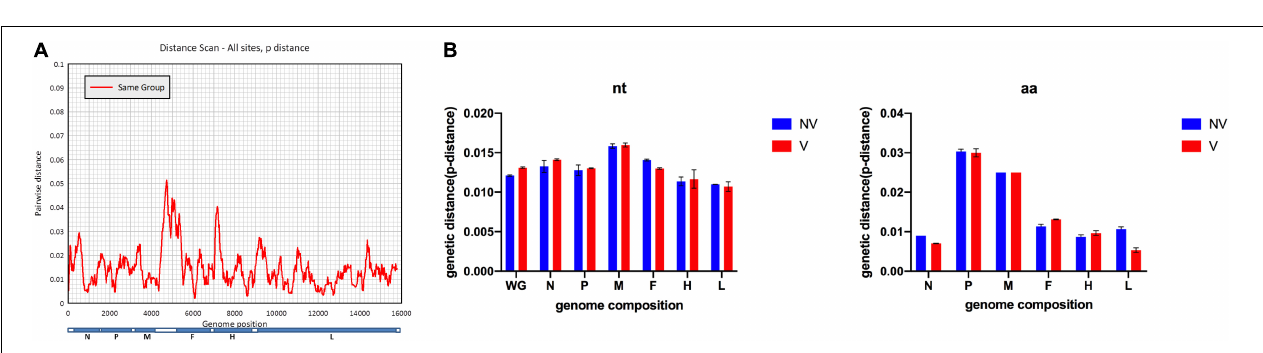
FIGURE 2 | Comparison of the vaccine group and non-vaccine group for characterizing the measles virus genome. (A) Pairwise distance based on 147 full-length measles virus sequences. (B) The estimated average divergence in individual genes is based on nucleotide (nt) sequences or predicted amino acid (aa) sequences.